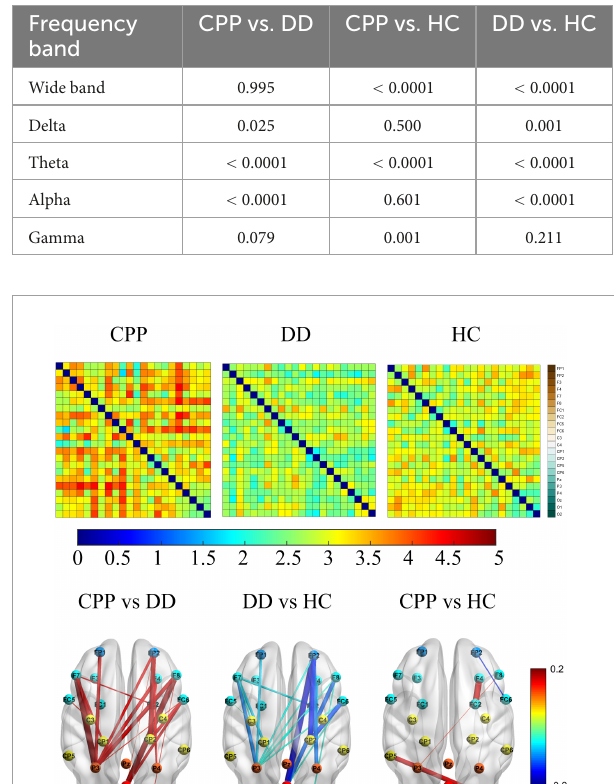
TABLE 4 Significant P -Values for post-hoc comparisons based on Tukey ’ s method of ANOVA.